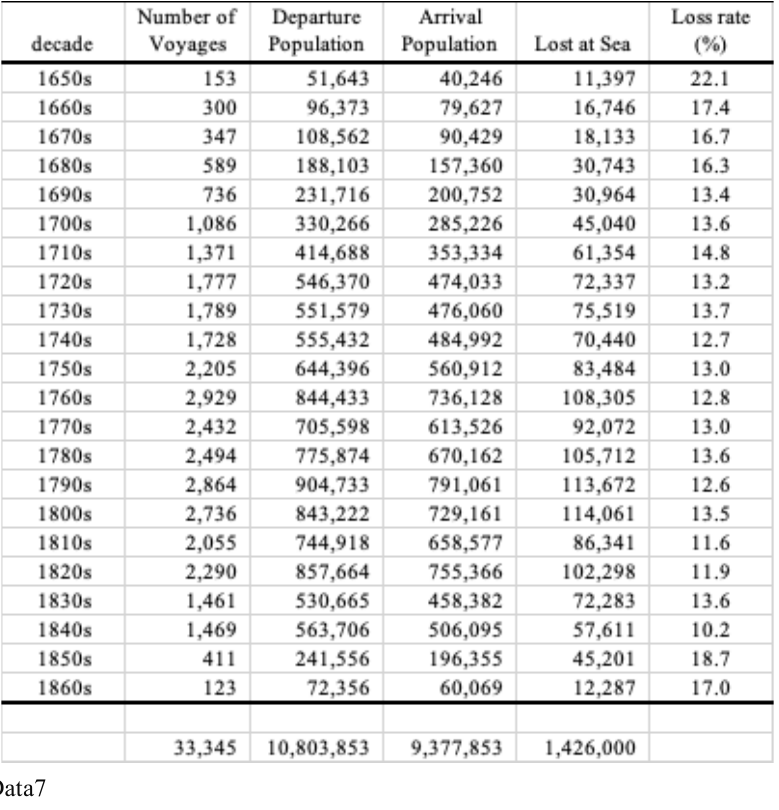
Table 4. Estimated total flows of